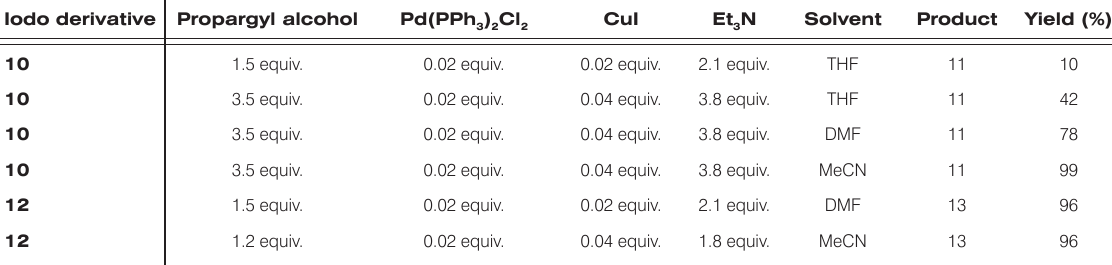
Table 1. Sonogashira reaction with 10 and 12 in different solvents. Iodo derivative Propargyl